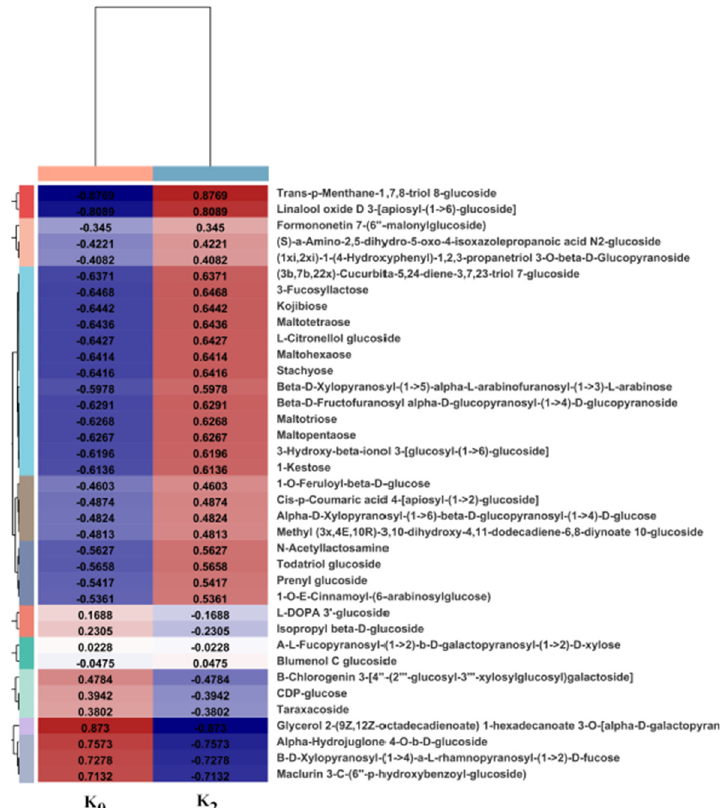
Figure 4. Cluster heat maps of polysaccharides and related compounds in lily bulb extracts. K con ‐ centrations: K 0 (0 mg ∙ L − 1 ), K 2 (671.4 mg ∙ L − 1 ). Each column represents a sample and each row represents a metabolite. The colors in the figure represent the relative expression levels of metabolites in a group of samples. The left-hand side shows the metabolite clustering tree and the right-hand side shows the names of the metabolite. The expression of two metabolites is closer when their branches are closer. Table 3. Differential metabolites of polysaccharides and related